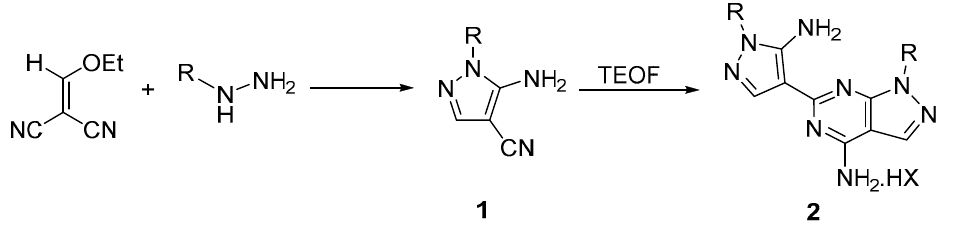
Figure 1. Synthesis of pyrazolo[3,4- d ]pyrimidine 2 from pyrazole 1 with Figure 35. Synthesis of pyrazolo[3,4- d ]pyrimidine 2 from pyrazole 1 with TEOF.